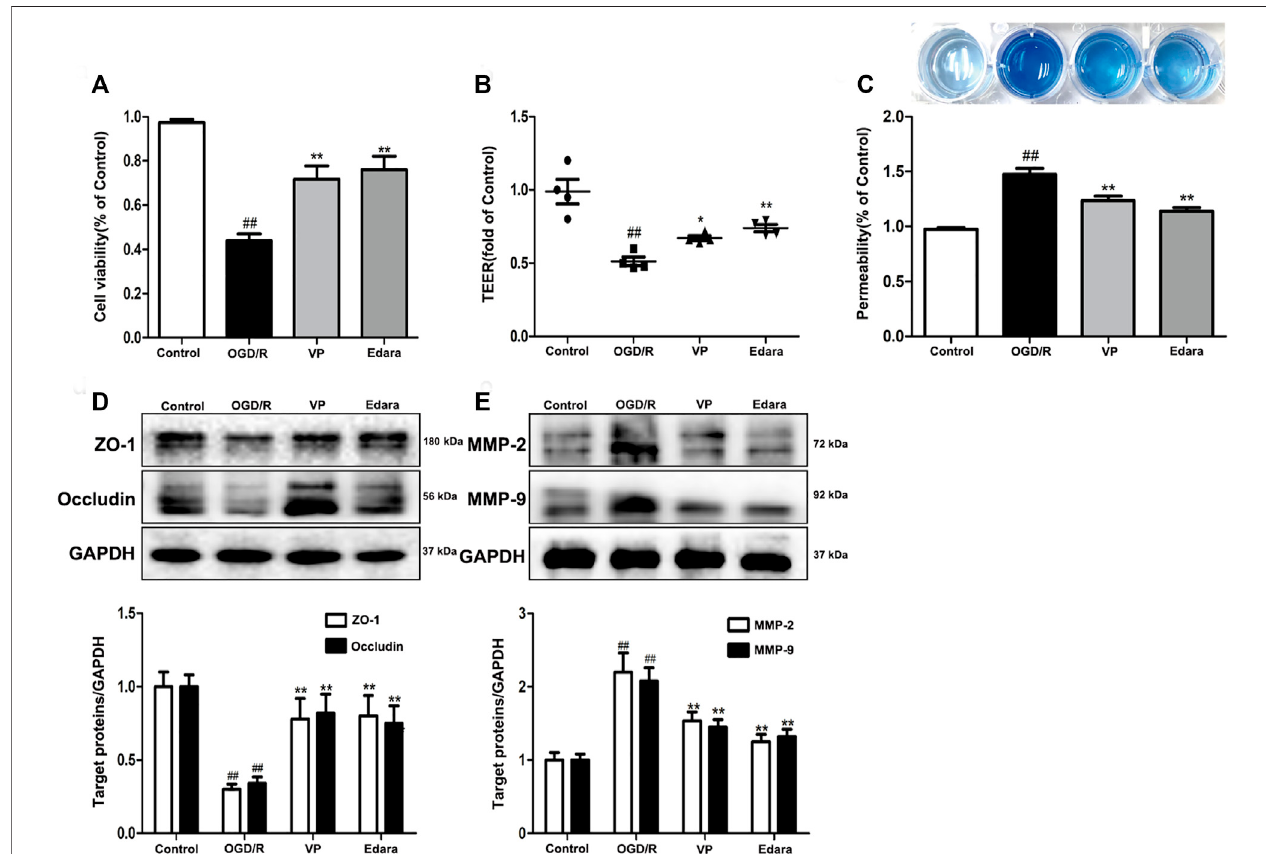
FIGURE7| EffectsofVPtreatmentonendothelialbarrierinjuriesinducedbyOGD/R.bEnd.3cellsweretreatedwithVP(1 µM)andsubsequentlyexposedto6 hof OGDand 6 hofreoxygenation. (A) Theprotectiveeffect ofVPin endothelial cellswasdetected byMTTassays. (B) and (C) Theprotectiveeffect ofVPon theendothelial cell barrier was detected using TEER and EB assays. (D) Representative western blots and quantitative analyses showing ZO-1 and occludin expression levels. (E) Representative western blots and quantitative analyses of MMP-2 and MMP-9 expression levels. Data are expressed as the mean ± SD, n (cid:1) 3. ## p < 0.01 vs . Control group, ** p < 0.01 vs . OGD/R